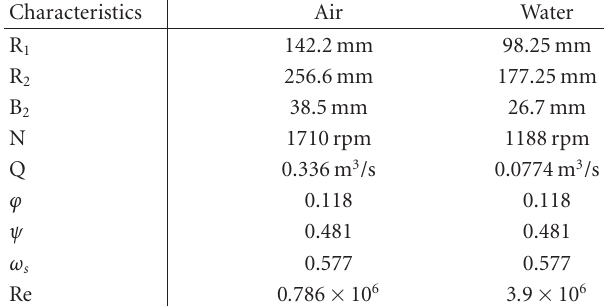
Table 1: Main characteristics of the test impellers.